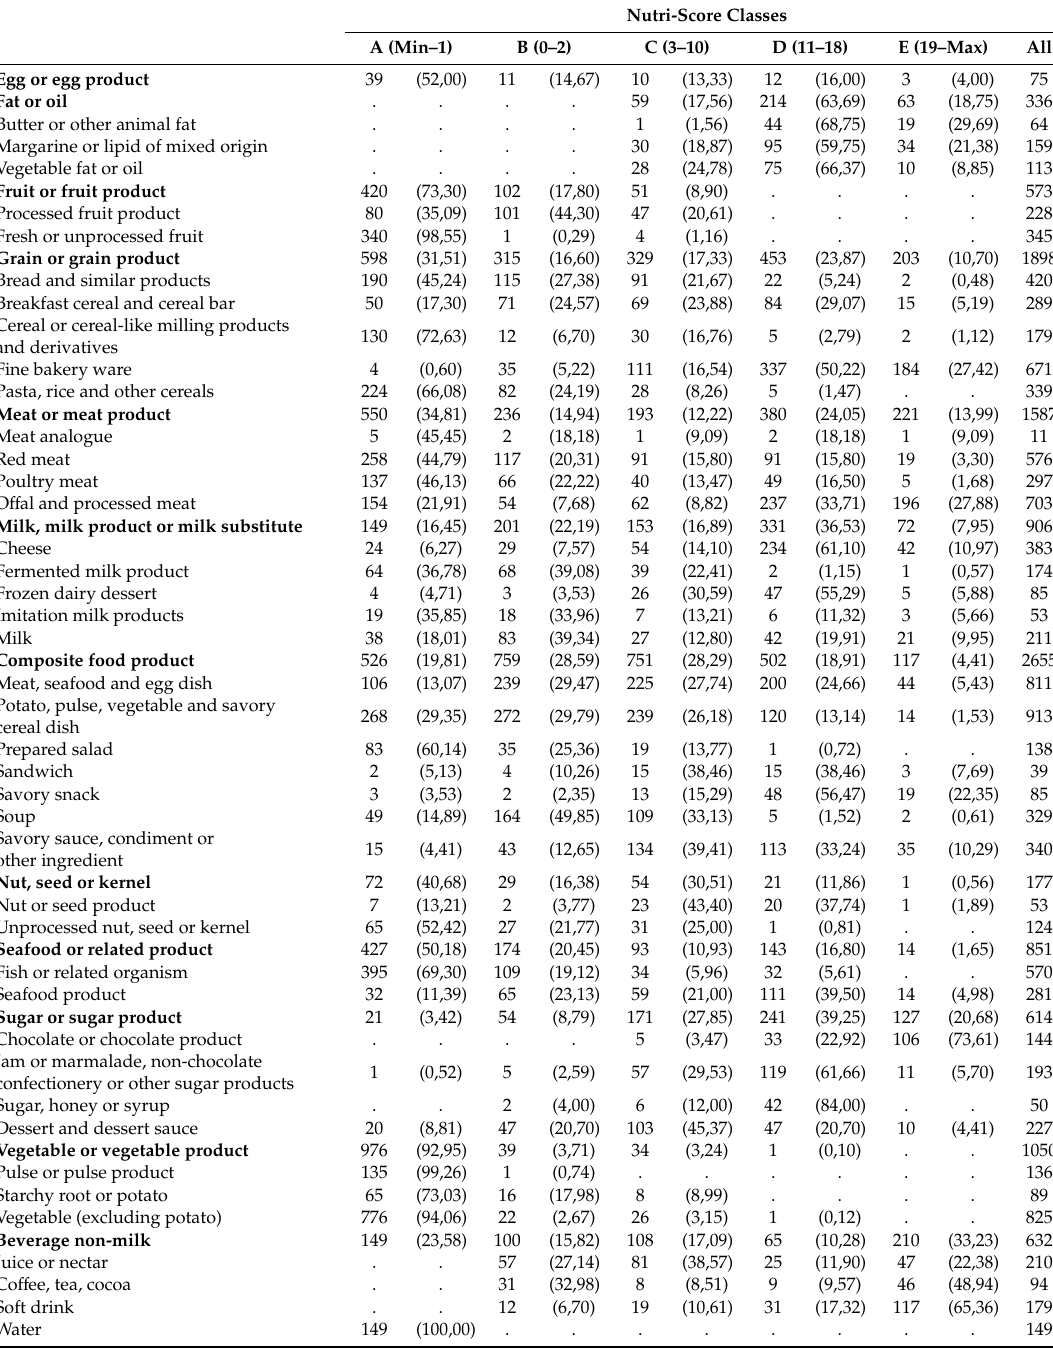
Table 1. Overall distribution (n, %) of the main food groups and subgroups in the Nutri-Score